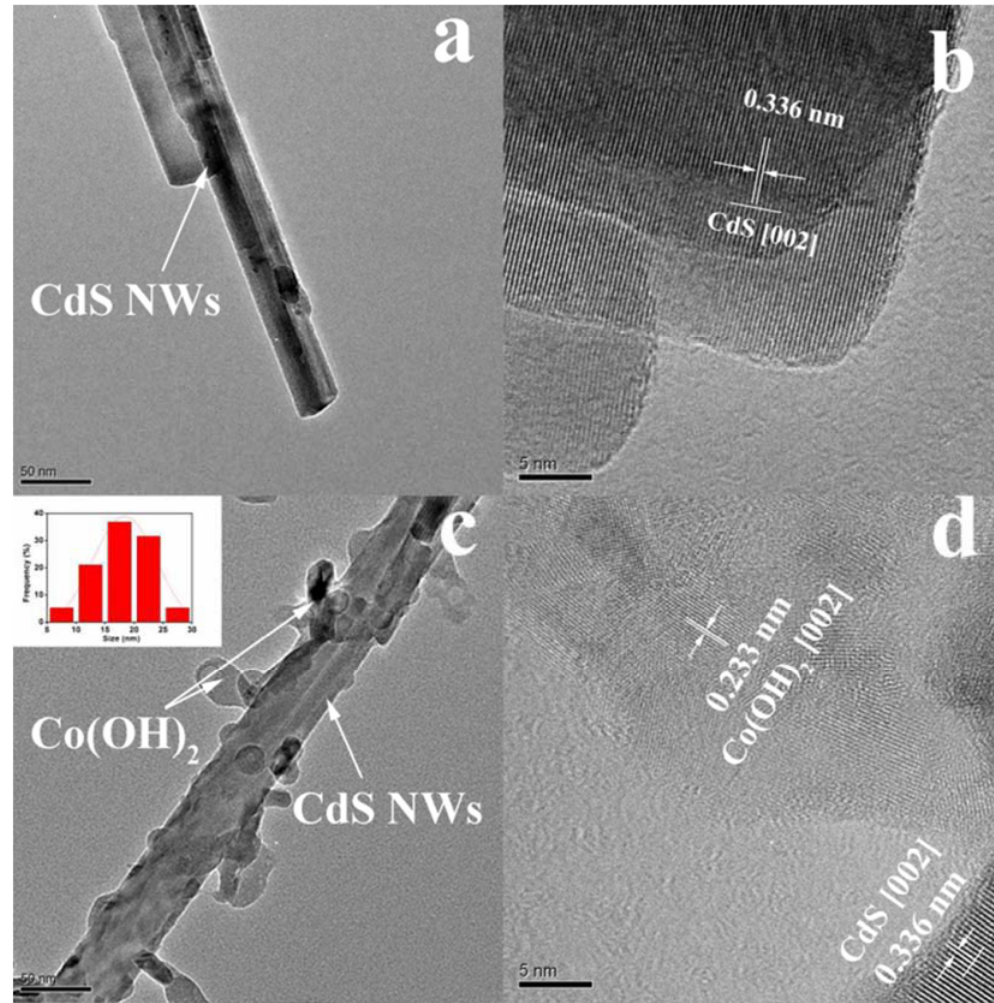
Figure 14. TEM and HRTEM images of ( a , b ) for CdS NWs. ( c ) (insert: the particle distribution of Co(OH) 2 clusters on CdS NWs) and ( d ) Co(OH) 2 /CdS NWs with a 6.5 mol% of Co(OH) 2 . Reproduced with permission from reference [129].